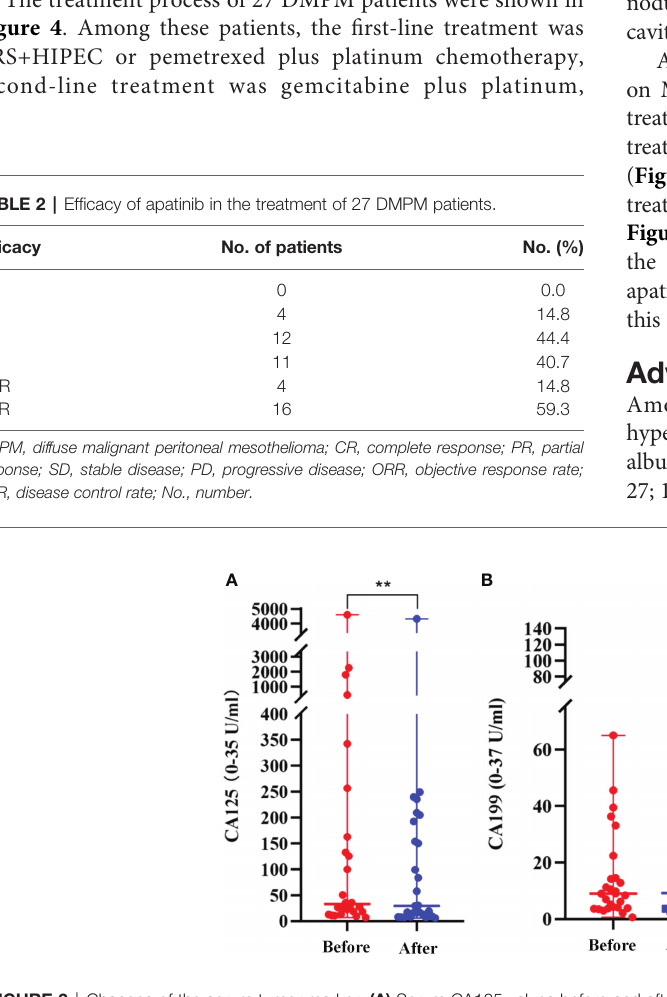
FIGURE 2 | Changes of the serum tumor marker. (A) Serum CA125 values before and after apatinib treatment (** P <0.01); (B) Serum CA199 values before and after apatinib treatment ( P =0.499); (C) CEA values before and after the apatinib treatment ( P =0.085).